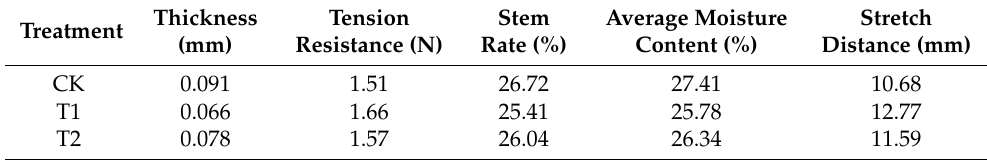
Table A1. Comparison of physical properties of cured tobacco leaves with different